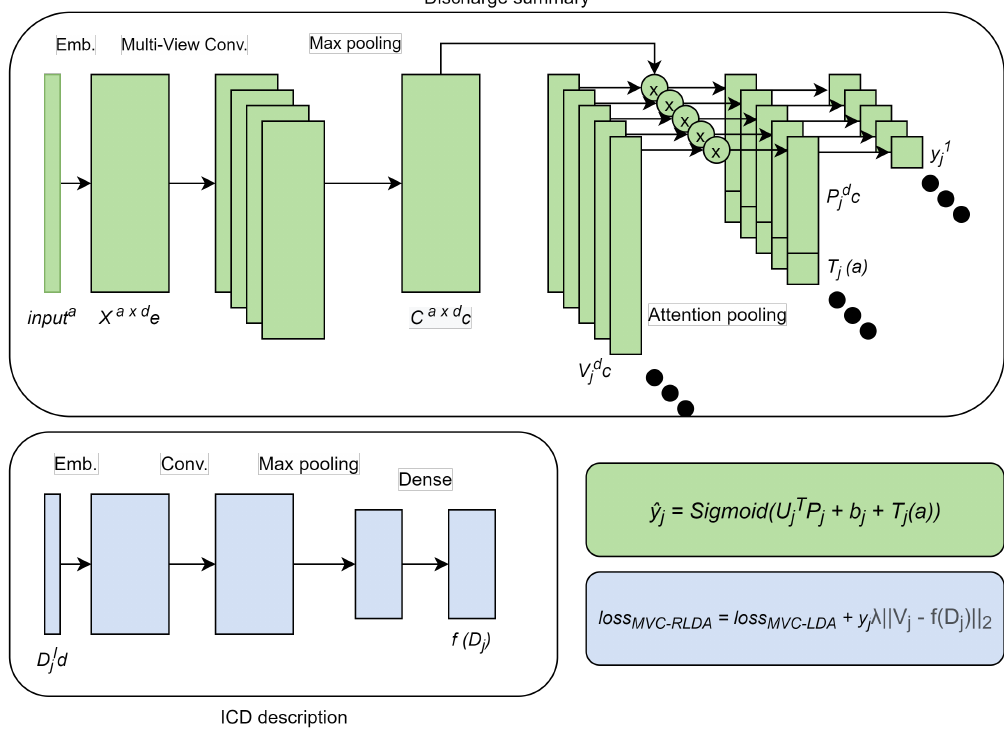
Figure 6. MVC-(R)LDA (after the work in